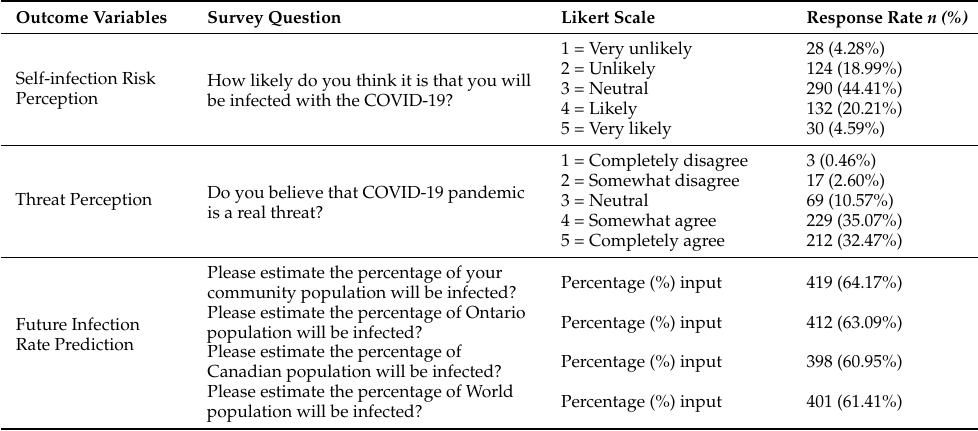
Table 2. Outcome variables’ breakdown in the model ( n =